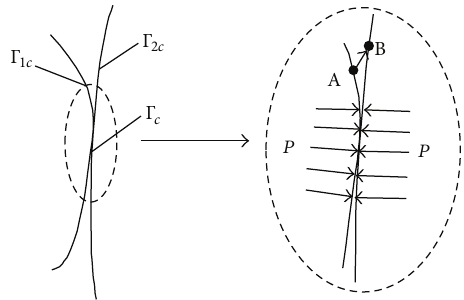
Figure 4: Contact analysis